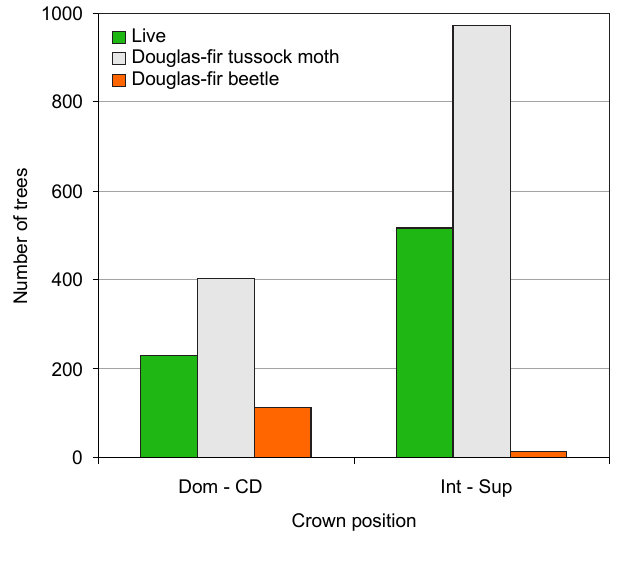
Figure 4. Total number (therefore no standard error) of live, Douglas-fir tussock moth-killed, and Douglas-fir beetle-killed trees across all plots and crown position classes; dominant and co-dominant (Dom-CD) and intermediate and suppressed (Int-Sup). Pike-San Isabel National Forest, City, Colorado, USA,